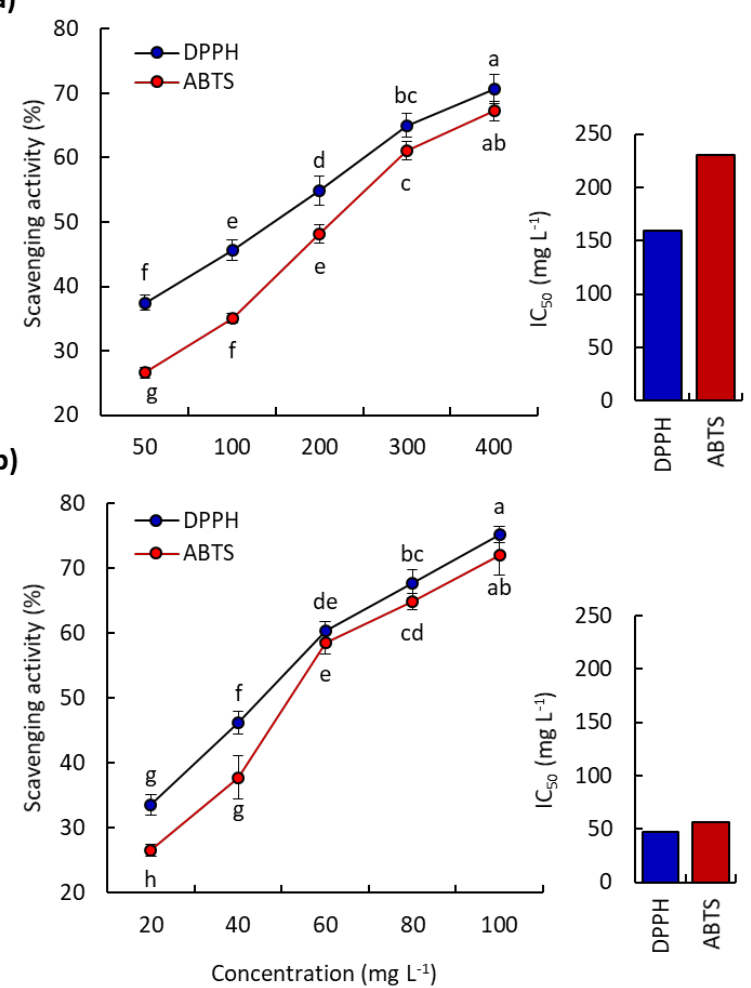
Figure 3. Antioxidant activity of Persicaria lapathifolia essential oil ( a ) and ascorbic acid as a standard antioxidant ( b ). Different letters mean a significant difference in values after Tukey’s HSD test ( p < 0.05).